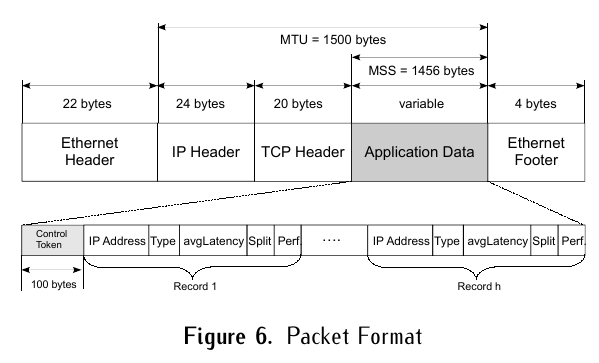
Figure 6. Packet